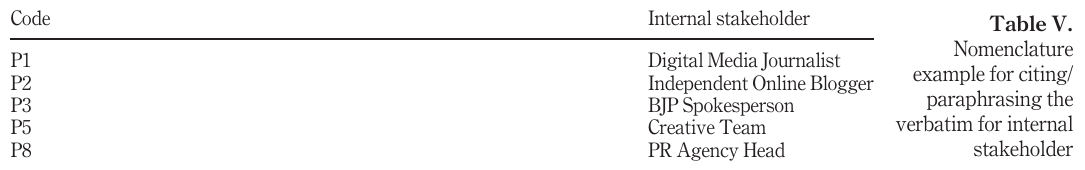
Table IV. Details of internal